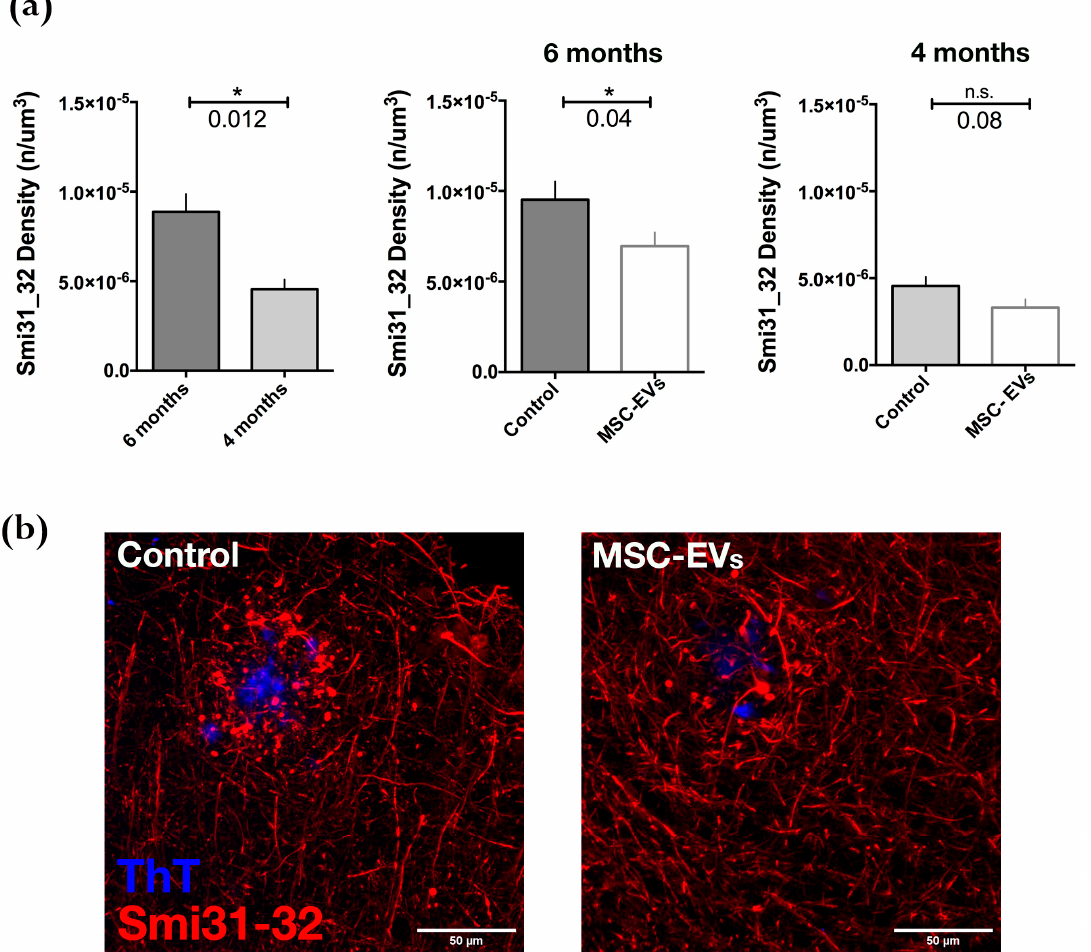
Figure 5. Dysmorphic Neurites around A β plaques in APP / PS1 brain cortex slices are reduced following MSC-EVs treatment. ( a ) Left panel: Quantification of Smi31-32 spots (density), representing dystrophic neurites, in the 3D reconstructed ROIs acquired around plaques in brain slices of 6- (dark grey histogram) and 4-month-old (light grey histogram) control APP / PS1 mice. Smi31-32 signal density in 6-month-old APP / PS1 brains is significantly reduced (central panel, white histogram), but not at 4 months (right panel). Statistical analysis was performed by non-parametric Mann-Whitney test (* p < 0.05). ( b ) Representative max projections of confocal images of brain slices of 6-month-old APP / PS1 mice 25 days following treatment with EVs (MSC-EVs) or with PBS (Control). Immunostaining with ThT (blue, A β plaques) and Smi31-32 (red, dystrophic neurites) are shown. Scale bars: 50 µm.